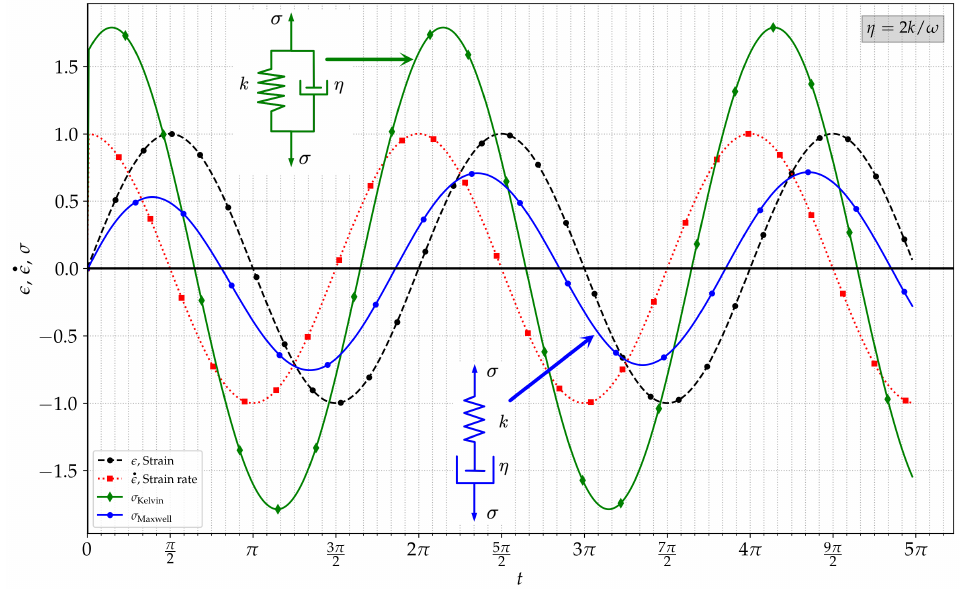
Figure 5. Strain, strain rate, and stress evolution in time for ideal Maxwell and Kelvin models forced with a synthetic strain (cid:101) = (cid:101) 0 sin ( ω t ) . Curves for (cid:101) = 1.0, ω = 1.0, k = 0.8, η = 2.0 k / ω